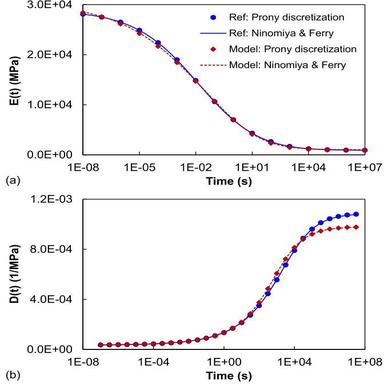
Kernel functions obtained from Prony representation and the Ninomiya and Ferry approximation method: (a) relaxation modulus, and (b) creep compliance.